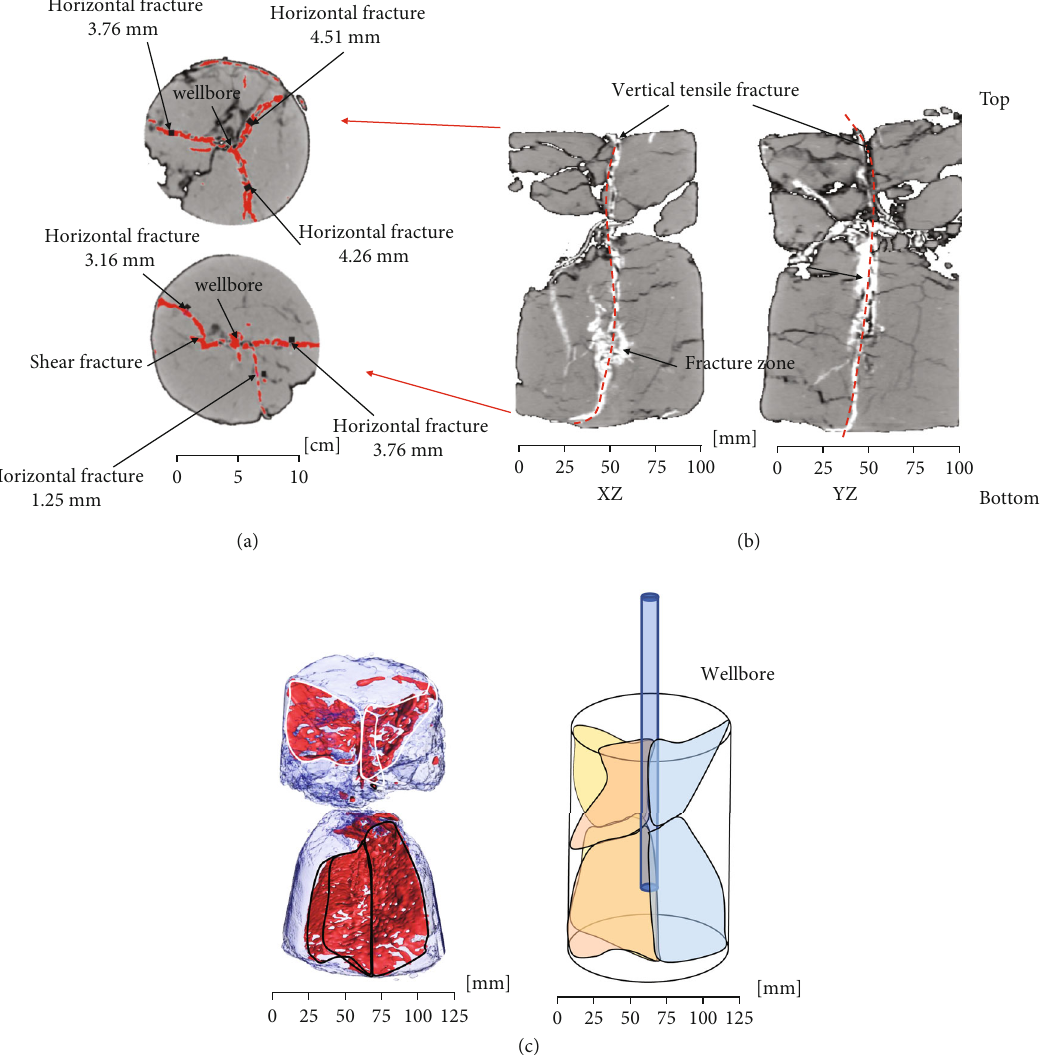
Figure 8: The fracture characteristics of sample 1 after hydraulic fracturing by CT: (a) CT section image, (b) CT perspective views, and (c) 3D